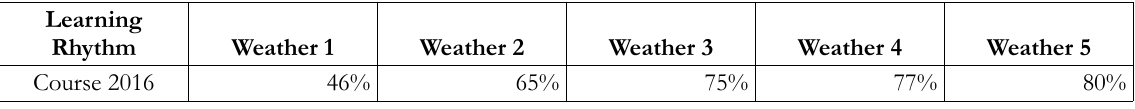
Table 2. The pace of learning experience